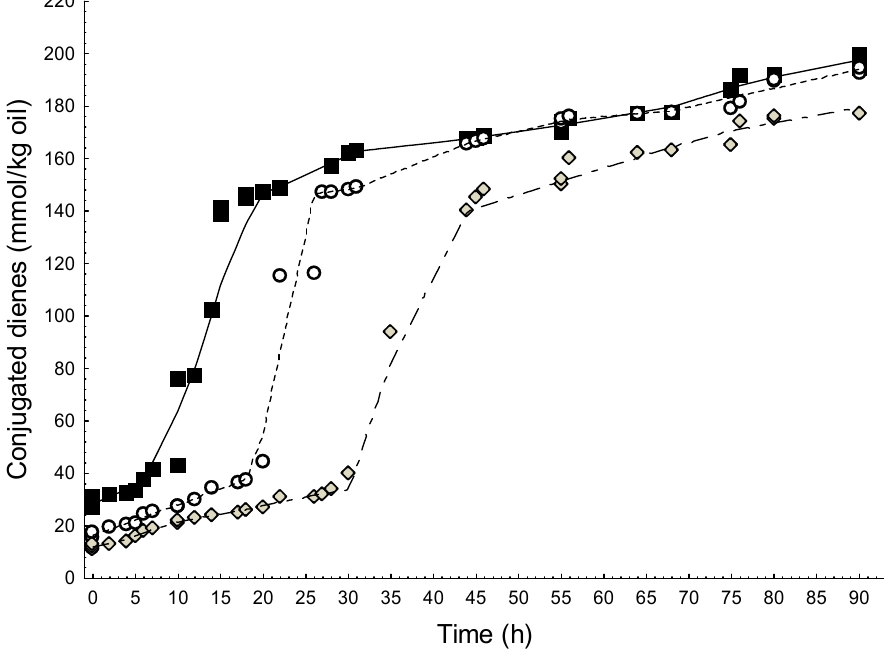
Figure 3. Production of conjugated dienes in sunflower o/w emulsions during oxidation in the dark at 50 °C for control emulsion ( ■ ), emulsion containing whole cranberry extract (WCE) ( ○ ), and emulsion containing 100 ppm BHT ( ◊ ). Each point represents a duplicate measurement.